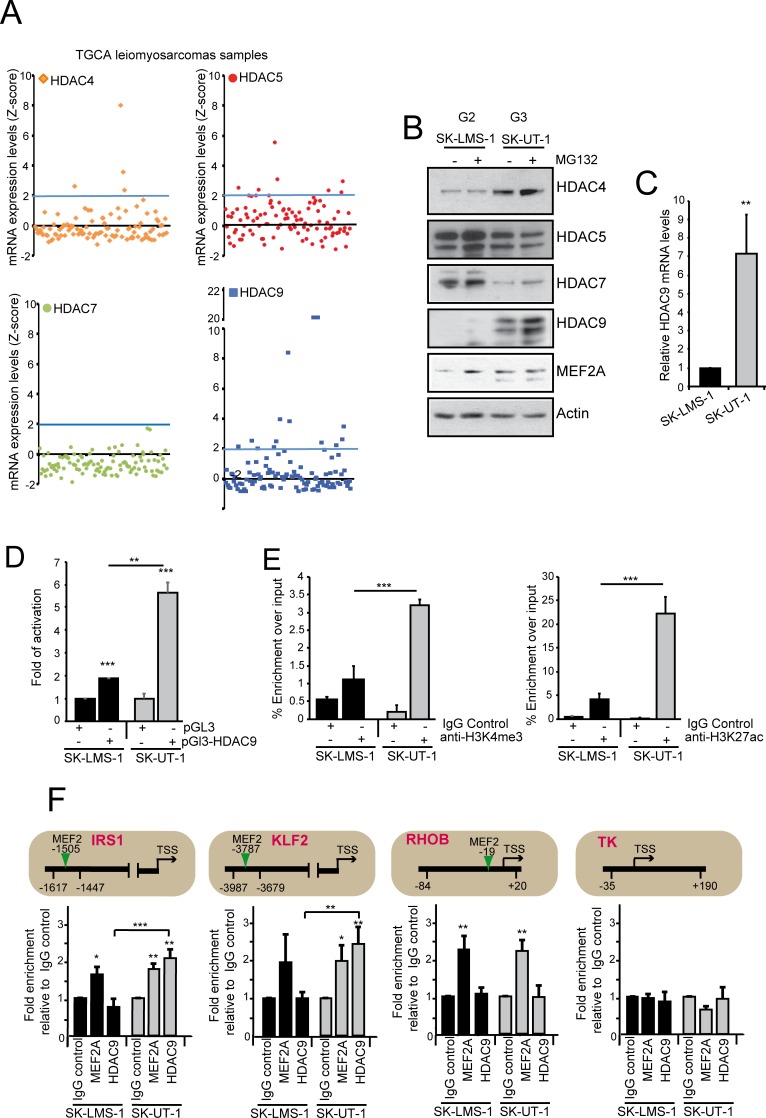
Class IIa HDACs expression in LMS.A) TCGA samples of leiomyosarcomas were analysed for the mRNA expression levels of the different class IIa HDACs. Individual tumors (n = 106) were aligned along the x axis. Data were extracted from CBio Portal (http://www.cbioportal.org/). B) Immunoblot analysis of class IIa HDACs family members and MEF2A in LMS cells. Cells were treated for 12 hours with 1μM of MG132. Actin was used as loading control. C) HDAC9 mRNA expression levels in the two LMS cell lines. Data are presented as mean ± SD; n = 3. D) Luciferase activity after transfection in LMS cells of the empty plasmid pGL3 or the same plasmid with cloned the HDAC9 promoter isolated from SK-LMS-1 cells (bp –1160/+23). The Renilla luciferase plasmid was used as an internal control. Data are presented as mean ± SD; n = 3. E) ChIP analysis of the chromatin status in the HDAC9 promoter. Chromatin was immunoprecipitated from SK-LMS-1 or SK-UT-1 cells using the anti-H3K4me3 and anti-H3K27ac antibodies. Normal rabbit IgGs were used as control. Data are presented as mean ± SD; n = 3. F) Chromatin was immunoprecipitated from SK-LMS-1 or SK-UT-1 cells using the anti-MEF2A and the anti-HDAC9 antibodies. Normal rabbit IgGs were used as control. TK promoter was used as negative control. The MEF2 binding site, the amplified region and the TSS are indicated for each tested gene, respectively with a vertical arrow, two arrowheads and a horizontal arrow. * p < 0.05, ** p < 0.01, *** p < 0.001